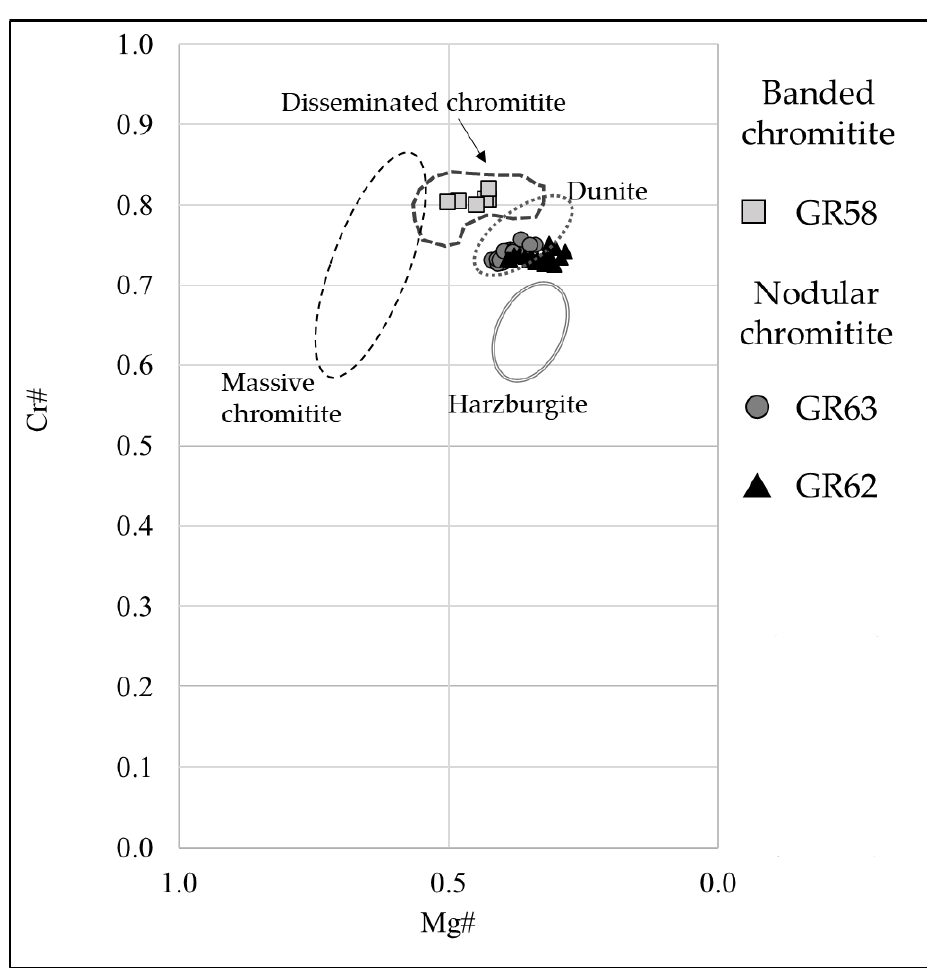
Figure 15. Cr# vs. Mg# of Nea Roda spinels; compositional fields of massive chromitite, harzburgite, dunite and disseminated chromitite are from Michailidis et al. [28].